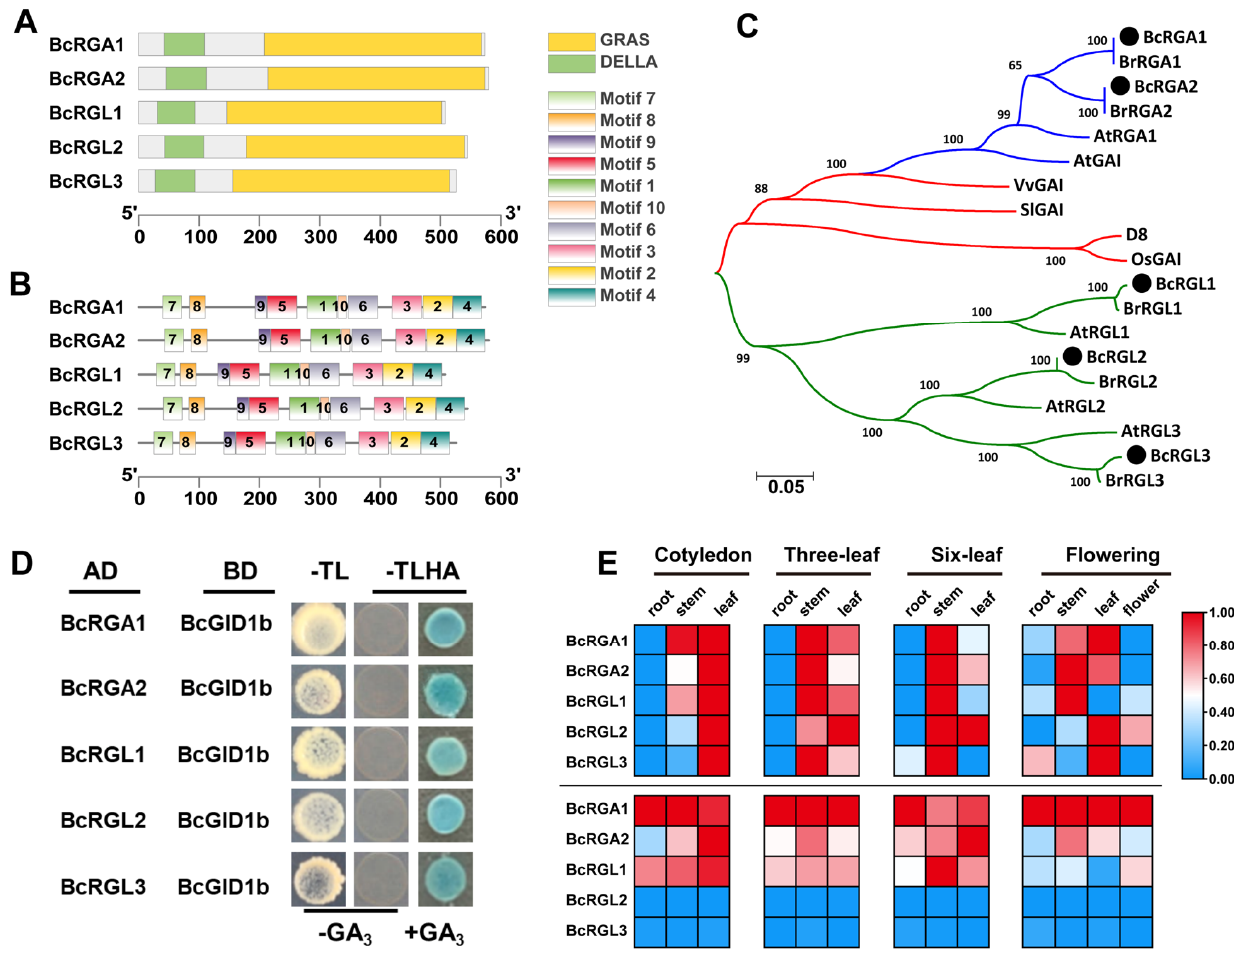
Figure 2. Characterization of DELLA proteins in flowering Chinese cabbage. ( A ) Conserved domain of the DELLA genes. Green and yellow represent the DELLA and GRAS domain, respectively. ( B ) Conserved motifs of the DELLA genes. Different motifs are represented by different colored boxes with numbers 1 − 10. ( C ) Phylogenetic tree of DELLA proteins in flowering Chinese cabbage and other species, as determined by the neighbor-joining method. The protein IDs used in the phylogenetic tree are AtRGA1 (NP_178266.1), AtGAI (NP_172945.1), AtRGL1 (NP_176809.1), AtRGL2 (NP_186995.1), AtRGL3 (NP_197251.1), BrRGA1 (XP_009101333.1), BrRGA2 (XP_009114228.2), BrRGL1 (XP_009127484.1), BrRGL2 (XP_009130367.1), BrRGL3 (XP_009107522.1), SlGAI (NP_001234365.1), D8 (NP_001354393.1), OsGAI (XP_015631543.1), and VvGAI (XP_002284648.1). ( D ) Detection of interactions among DELLA proteins and BcGID1b using Y2H. Yeast cells with different construct combinations were grown on selective media without Trp and Leu (-TL) and were tested for interac- tions on selective media without Trp, Leu, His, and Ade ( − TLHA). ( E ) Expression profiles of flowering Chinese cabbage DELLA genes in various organs. Above the line is a horizontal comparison, with each column exhibiting normalization independently, and below the line is a vertical comparison, with each row displaying normalization independently. GA 3 , gibberellin